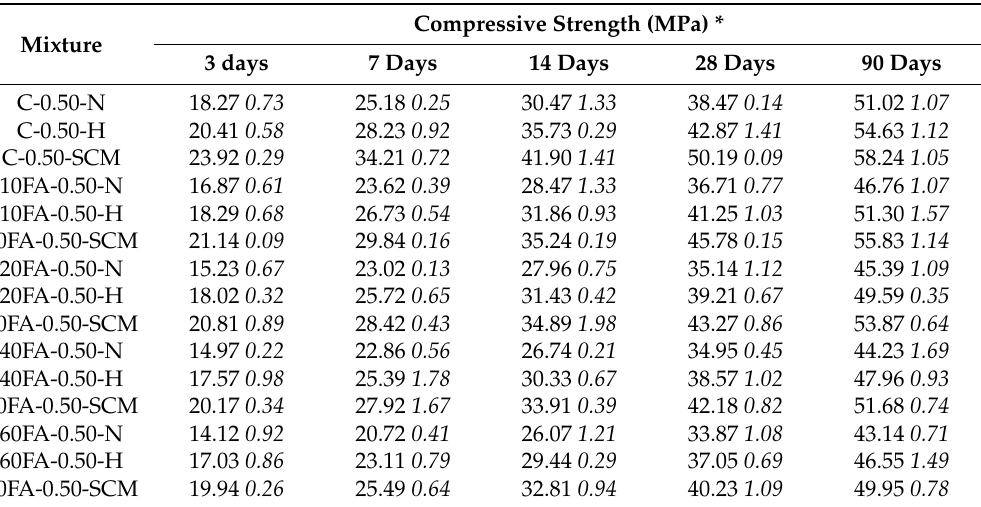
Table A4. Compressive strength for w/b